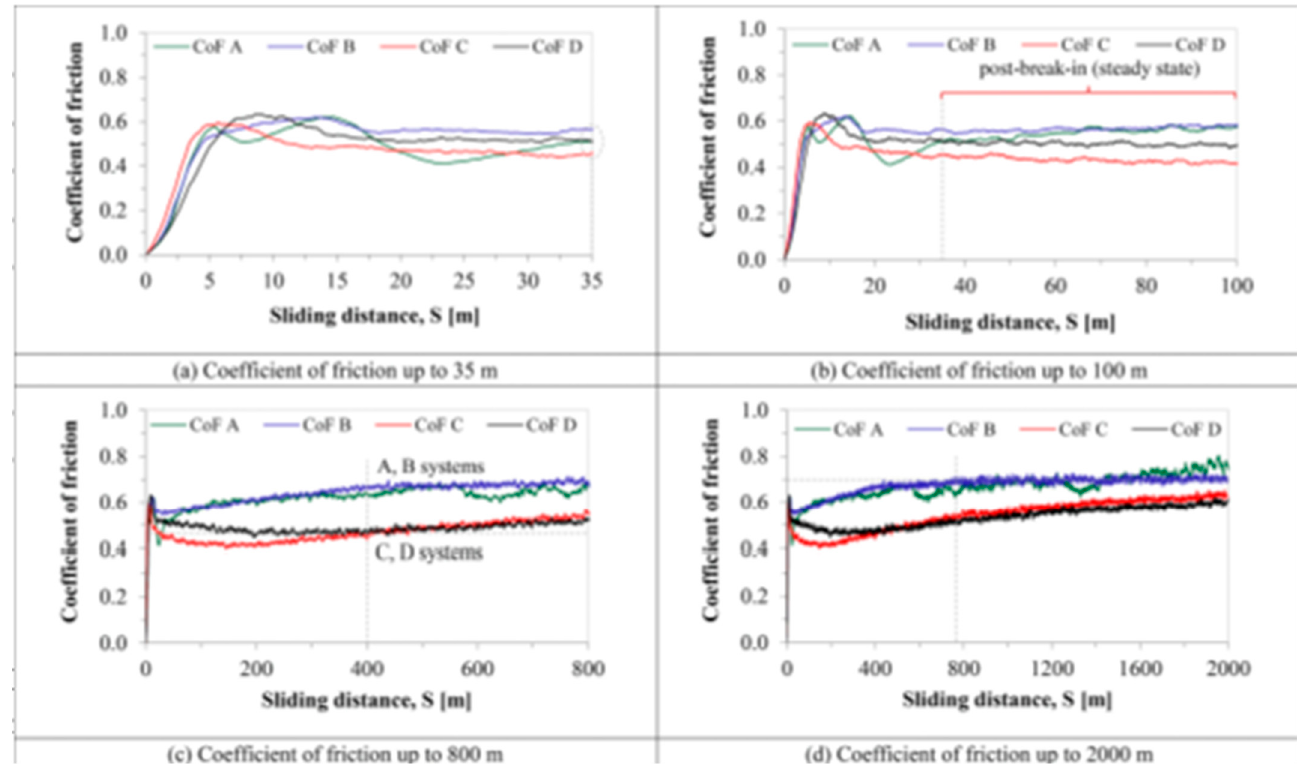
Figure 11. Change in the CoF with sliding distance. ( a ) AISI H13 steel; ( b ) H13 + SM-SEDM]; ( c ) H13 + SM-SEDM + TiAlN; ( d ) H13 + SM-SEDM + SR + TiAlN [90]. (With kind permission from Elsevier) .